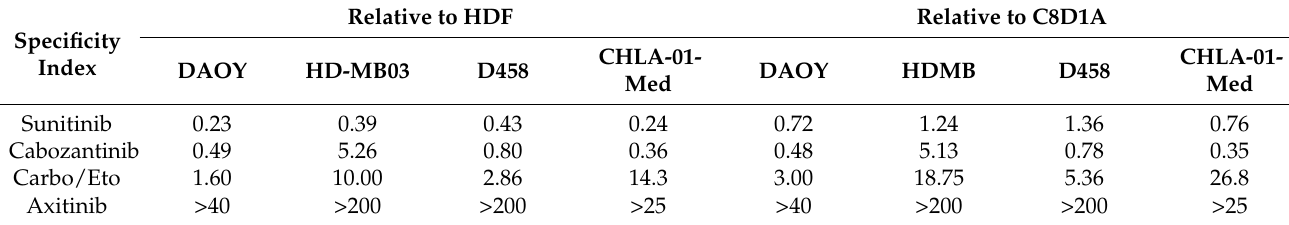
Table 2. Specificity indexes for three antiangiogenic compounds and reference chemotherapy in normal and MB cells. Specificity indexes were determined by calculating the ratio between the IC50 of a given drug for either human dermal fibroblasts (HDF) or murine primary astrocytes (C8-D1A) and the IC50 of the same drug for each of the MB cell lines (D458, DAOY, HD-MB03 and